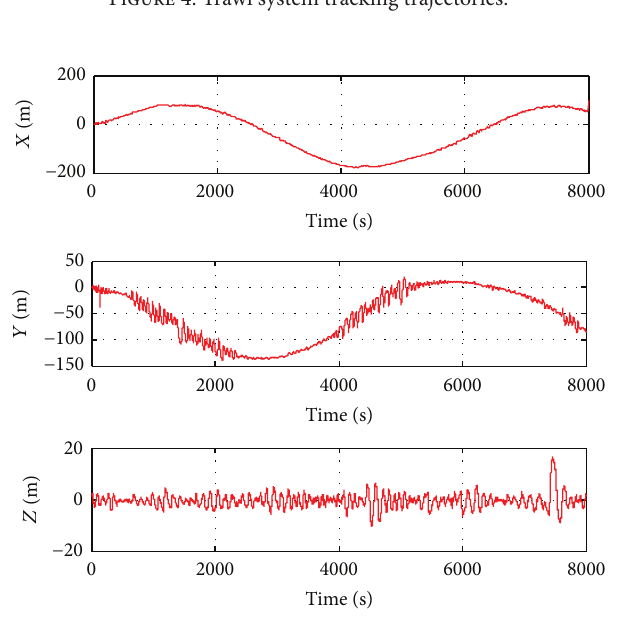
Figure 5: Tracking